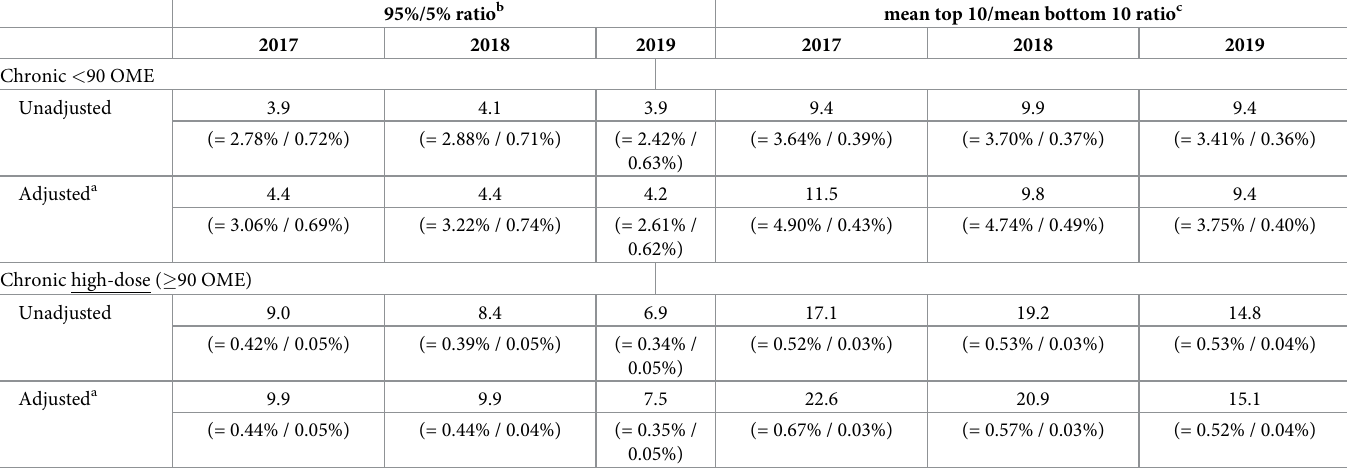
Table 2. Variation scores for chronic high-dose ( � 90 OME) use and chronic < 90 OME prescriptions across years. The proportions on which the ratios are based is shown in